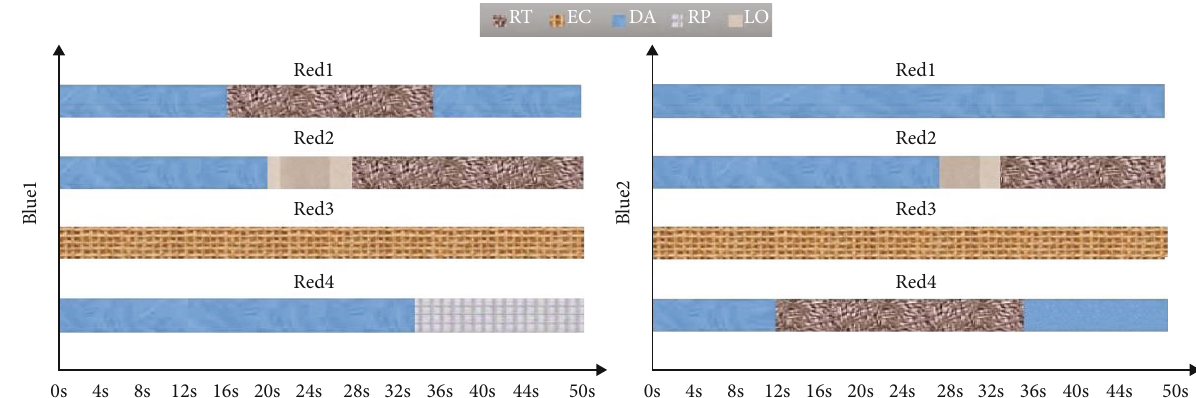
Figure 17: General tactical intention recognition results. The left picture shows the identi fi cation results of the four red fi ghters by blue1, and the right picture shows the identi fi cation results by blue2. This is a horizontal stacked bar chart with di ff erent patterns representing the corresponding general tactical intentions. The legend at the top of the picture gives the corresponding label of these patterns.